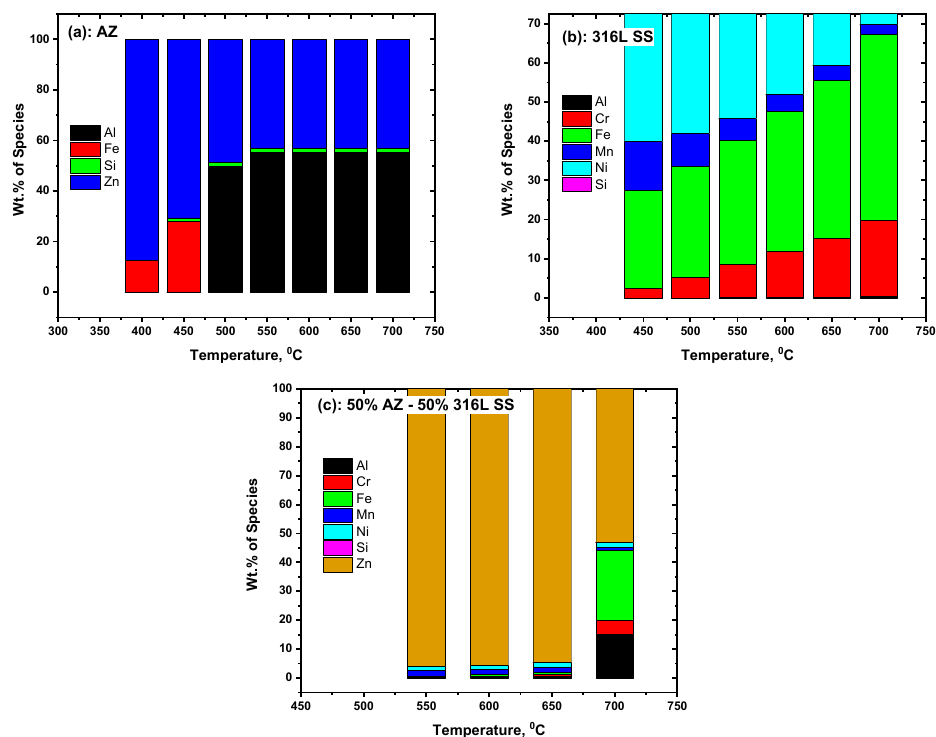
Figure 5. Equilibrium compositions of the liquid phase in the ( a ) AZ coating and ( b ) SS base metal ( c ) at the interface of the base metal and the coating (optimized for 50% AZ and 50% SS) at incremental processing temperatures to 700 °C.